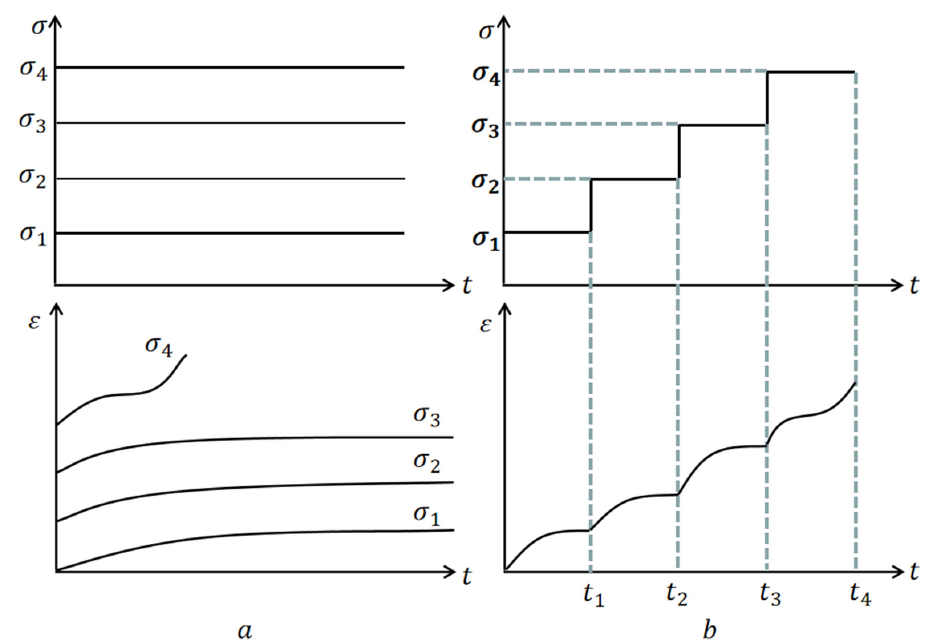
Figure 1. ( a ): RL mode and corresponding creep strain–time curves. ( b ): SL mode and corresponding creep strain–time curves [2].